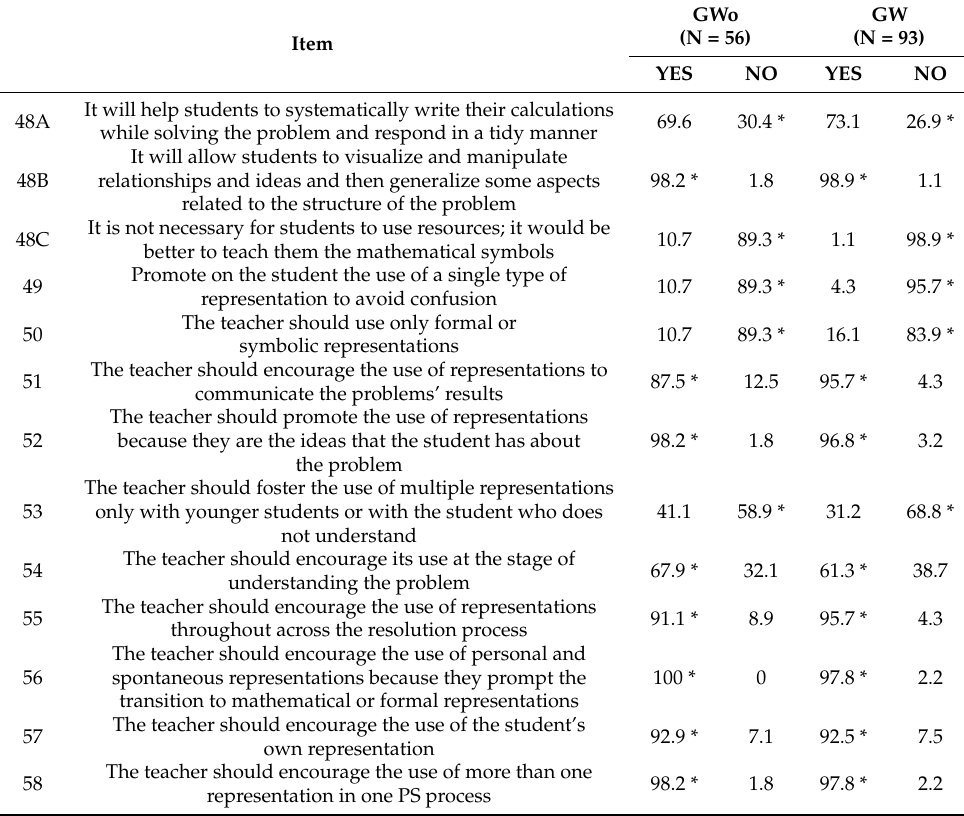
Table 8. Percentages of responses of knowledge of resources PS